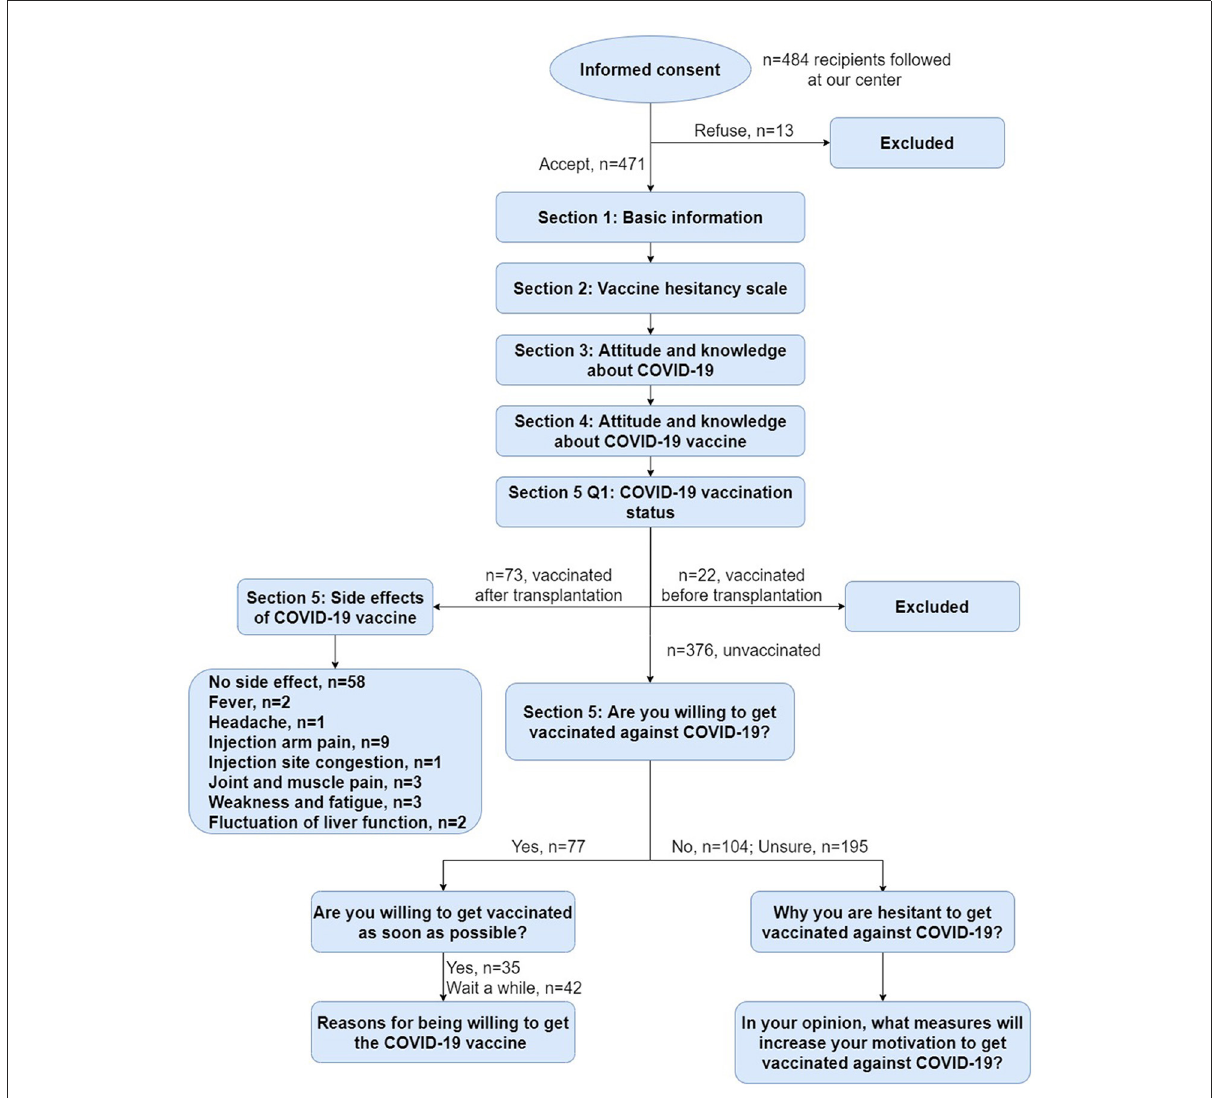
FIGURE1 The flow chart for the five sections of the